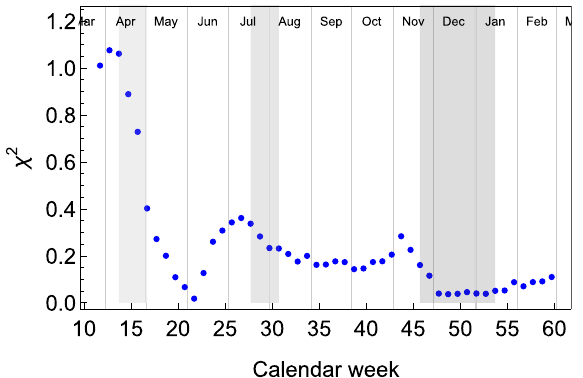
2 over time (weekly basis). The shaded bands indicate the